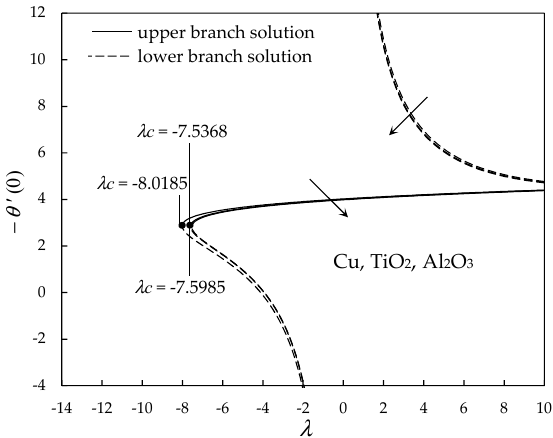
Figure 15. Variation of the reduced local Nusselt number − θ (cid:48) ( 0 ) with the mixed convection parameter λ when φ = 0.01, Nr = 0.1, K = 0.1, s = 1 and c = − 1 for Cu-water, Al 2 O 3 -water and TiO 2 -water nanofluids.